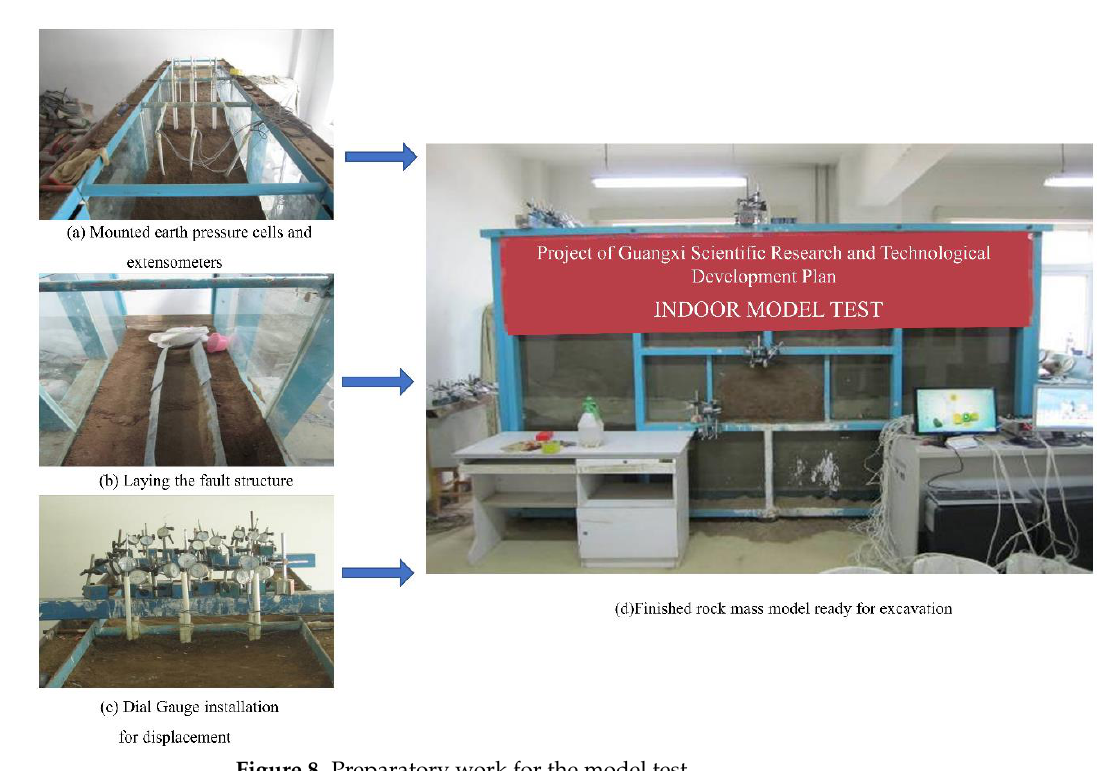
Figure 8. Preparatory work for the model test.